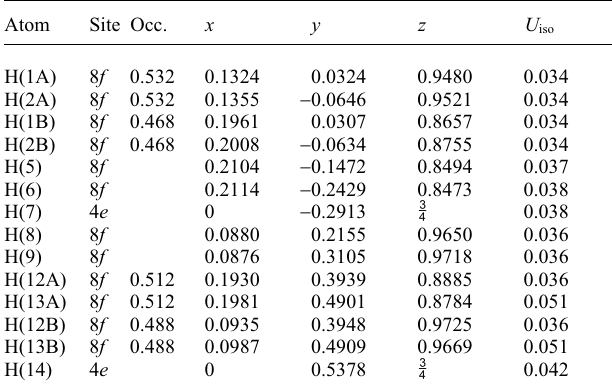
tral Pd(II) ion has a trans -Br N square-planar coordination 2 2 geometry defined by two N atoms from two 4-phenylpyridine lig- ands and two bromido ligands. The two Pd–N bond lengths are nearly equal with d (Pd–N) = 1.996(5) and 2.036(6) Å, and the N–Pd–Br bonds are almost perpendicular (<N–Pd–Br = 88.89(2)° and 91.11(2)°). In the refinement, the pyridine ring N1- C3 and the benzene ring C11-C14 were found to be disordered over two sites with the site-occupancy factors of 0.532(16) and 0.512(8), respectively, for the major components. The dihedral angles between the major and minor rings are 29(1)° for the ring N1-C3 and 37.5(8)° for the ring C11-C14, respectively. The mol- ecules are stacked in columns along [100]. Table 1. Data collection and handling. Table 2. Atomic coordinates and displacement parameters (in Å 2 )